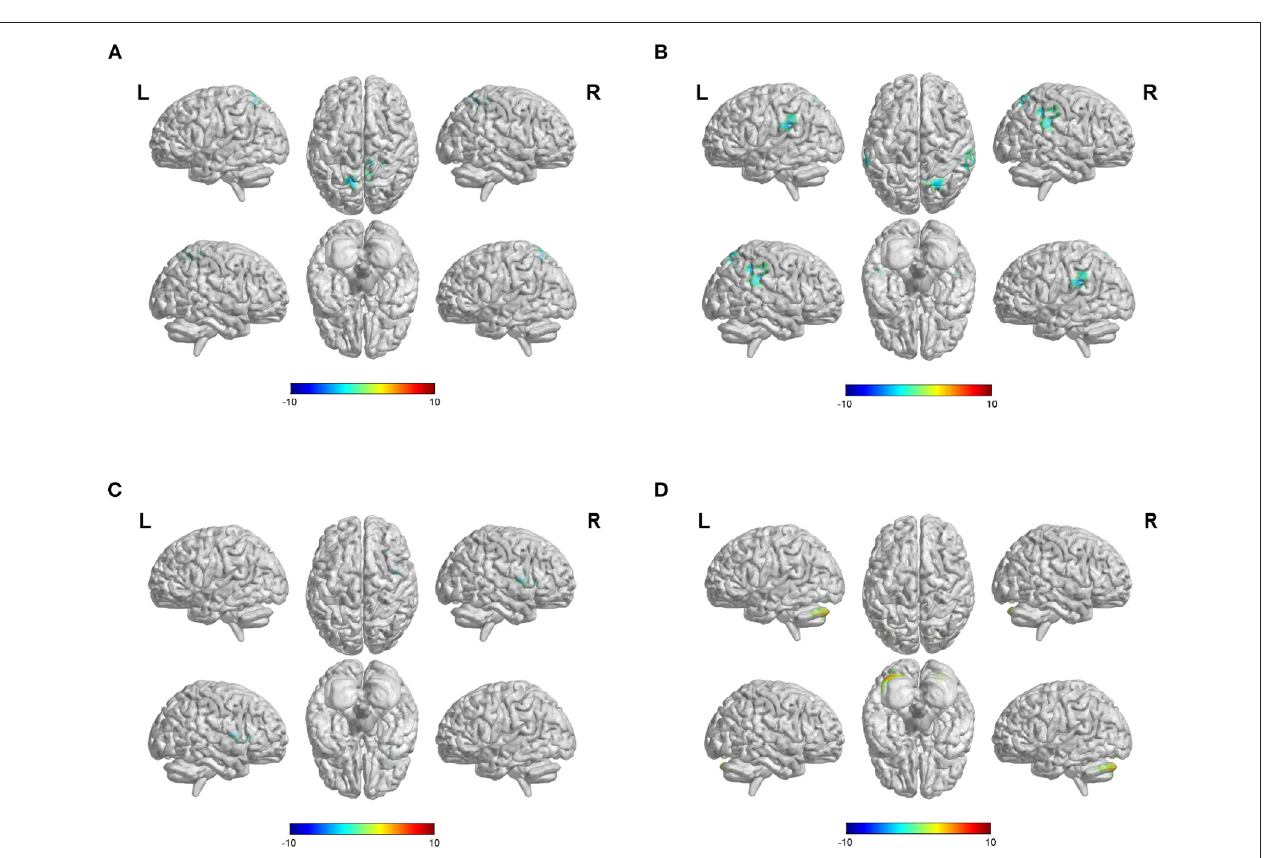
FIGURE 2 | Difference of FC values when select different ROIs. (A) Differences of FC values in the posterior cingulate cortex (PCC). (B) Differences of FC values in the anterior cingulate cortex (ACC). (C) Differences of FC values in the putamen. (D) Differences of FC values in the superior frontal gyrus (SFG). FC, functional connectivity; ROI, region of interest; Gaussian random field correction, voxel-level p < 0.001, cluster size > 100 voxels; The color bar represents T statistics. The red areas represent the regions which have increased FC, while the blue ones represent the regions which have decreased